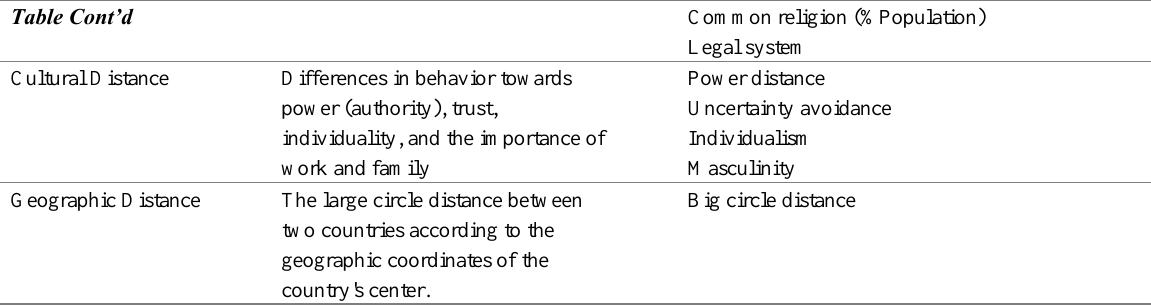
Legal system Power distance Uncertainty avoidance Individualism Masculinity Big circle